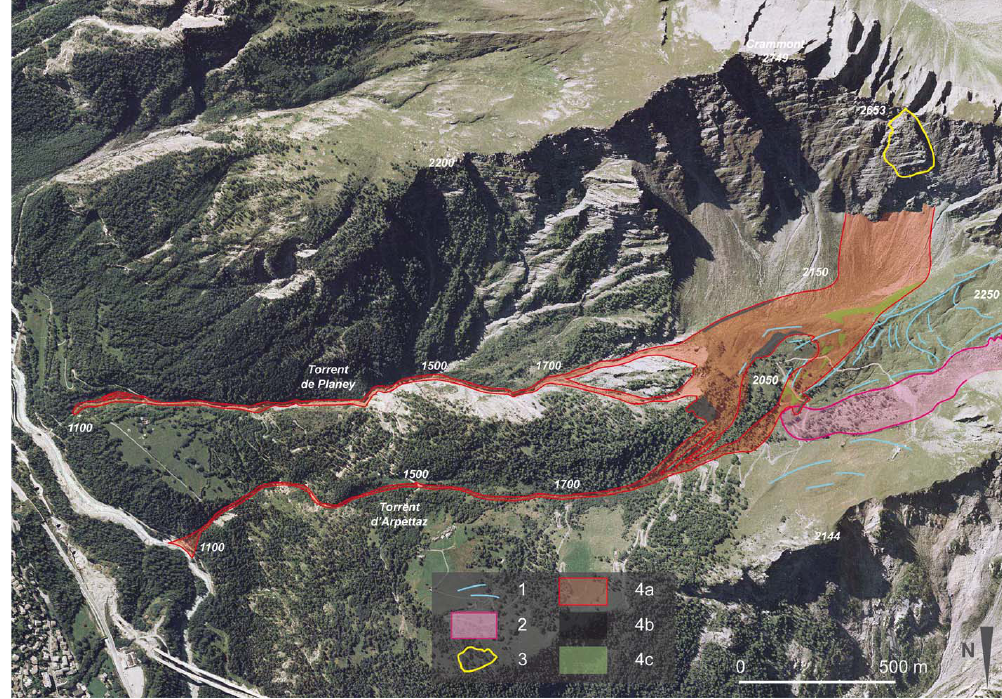
Fig. 6. Map of the Crammont area, with main geomophological elements. 1: Lateglacial moraines; 2: old rock-avalanche deposit; 3: 2008 rock-avalanche source zone; 4: 2008 rock-avalanche deposit (4a: rock deposit; 4b: scoured area; 4c: splash area). Elevations are in ma.s.l.; 2008 orthophoto.